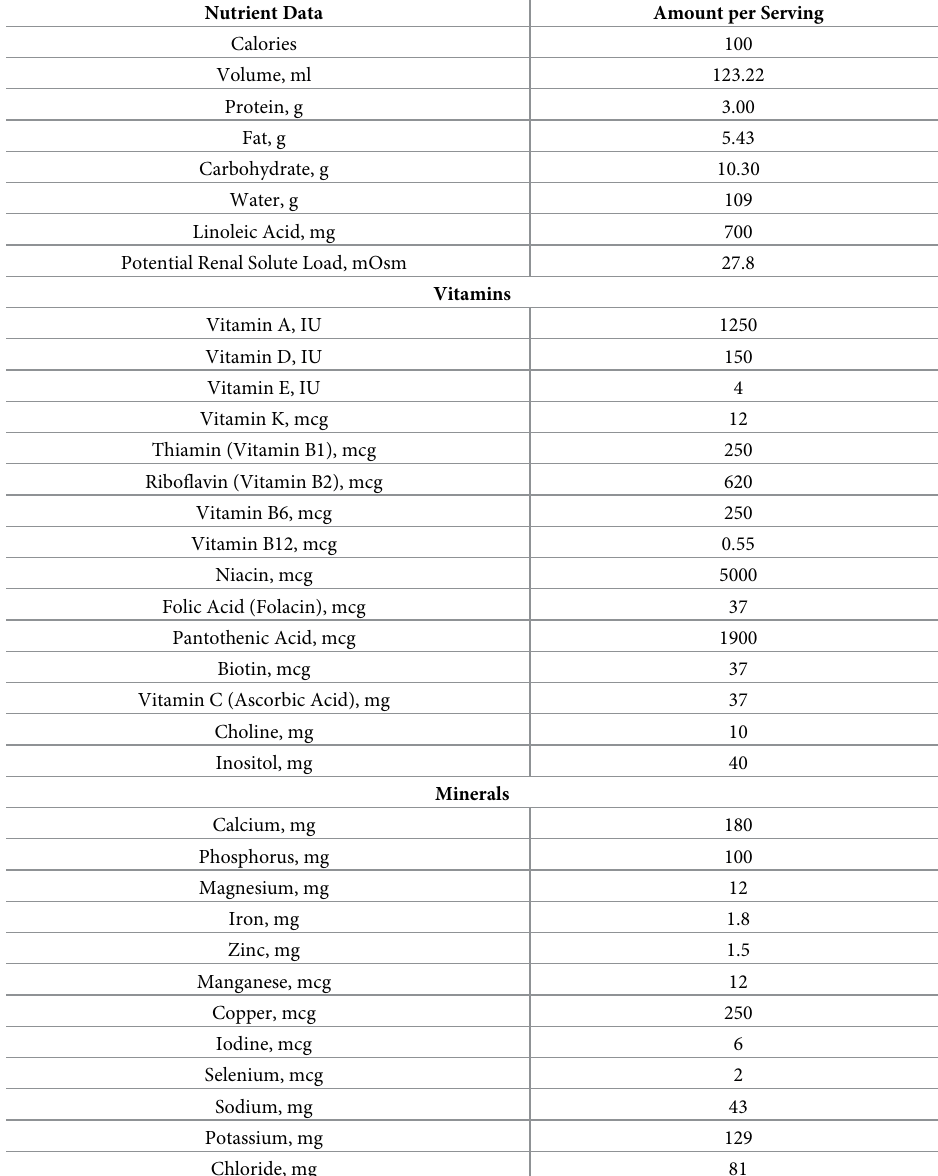
Table 1. Composition of Similac Special Care 24 nutritional formula, manufactured by Abbott Nutrition, USA